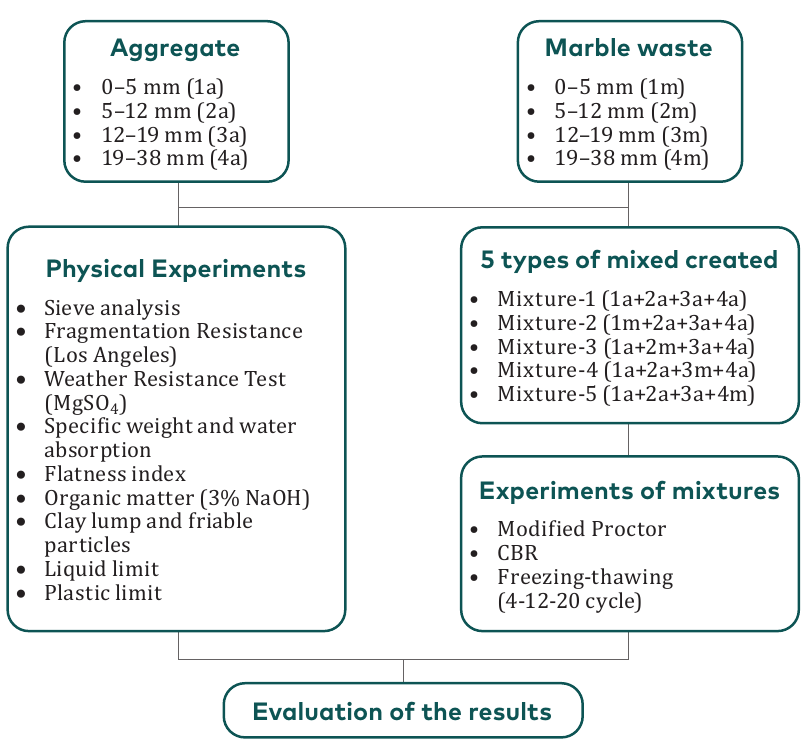
Figure 4. The flow chart of preparation of mixes and tests done